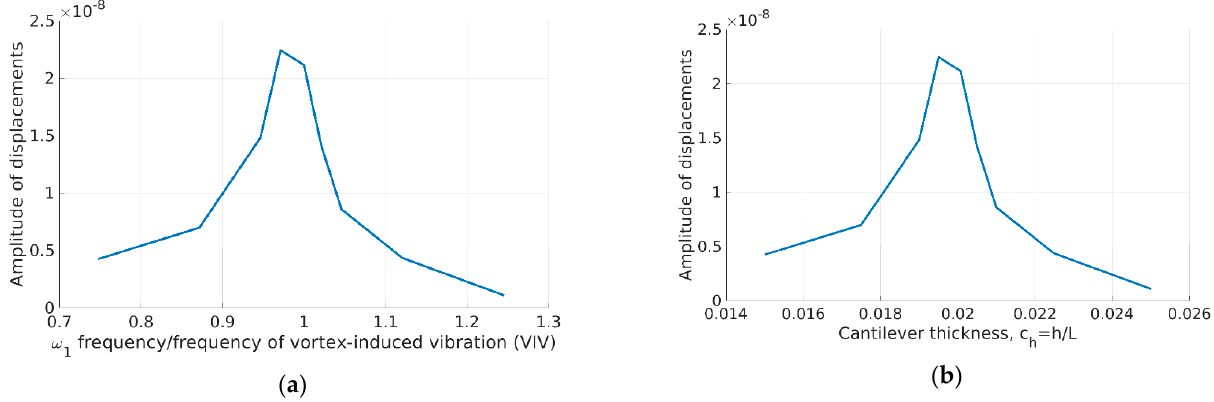
Figure 10. Amplitude of displacement of beam as a function of ( a ) frequency ratio (first natural frequency over VIV frequency) and ( b ) cantilever